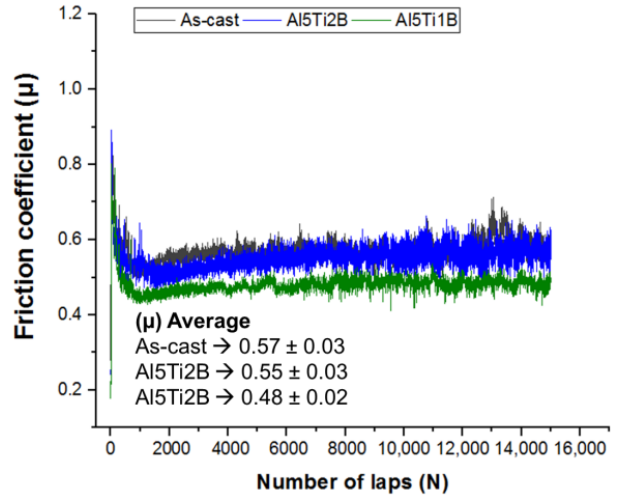
Figure 12. Friction coefficient in the ball-on-disk testing.